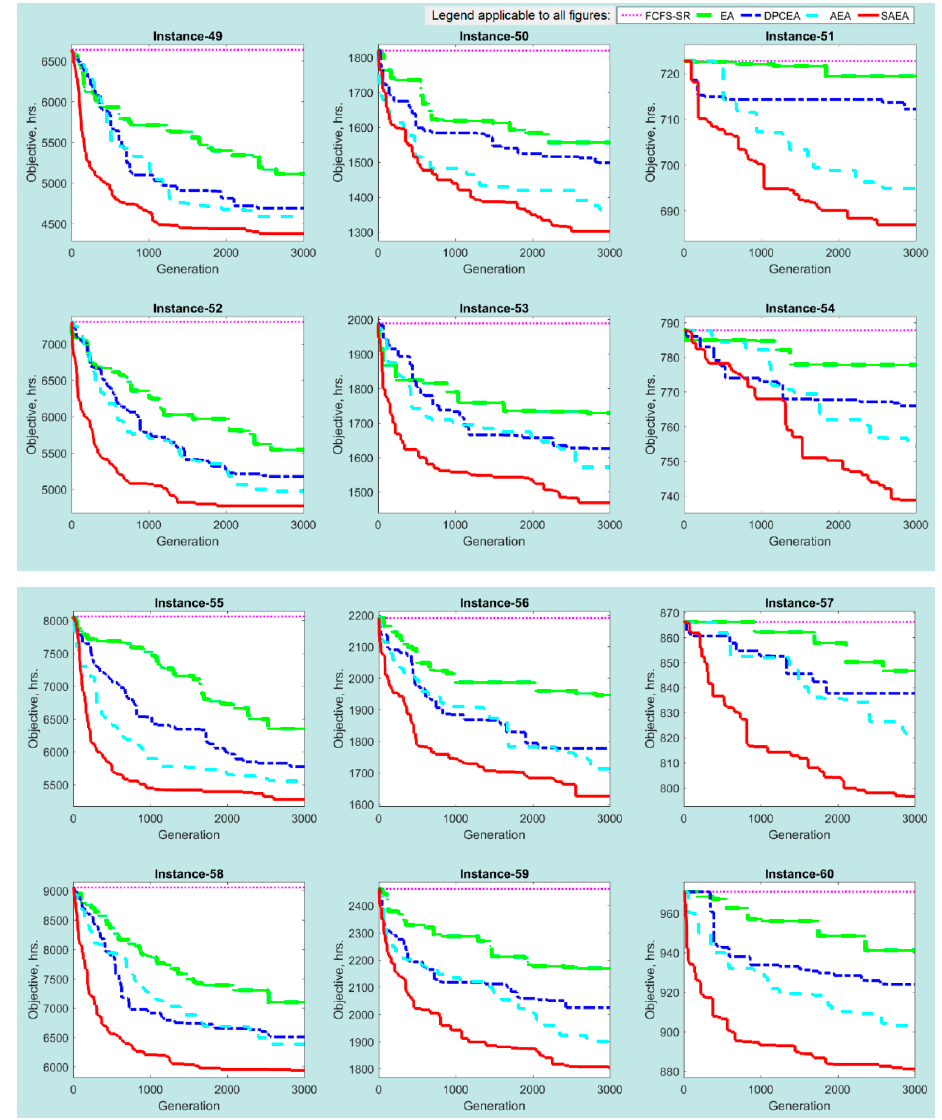
Figure 10. The algorithmic convergence patterns for problem instances 49–60.